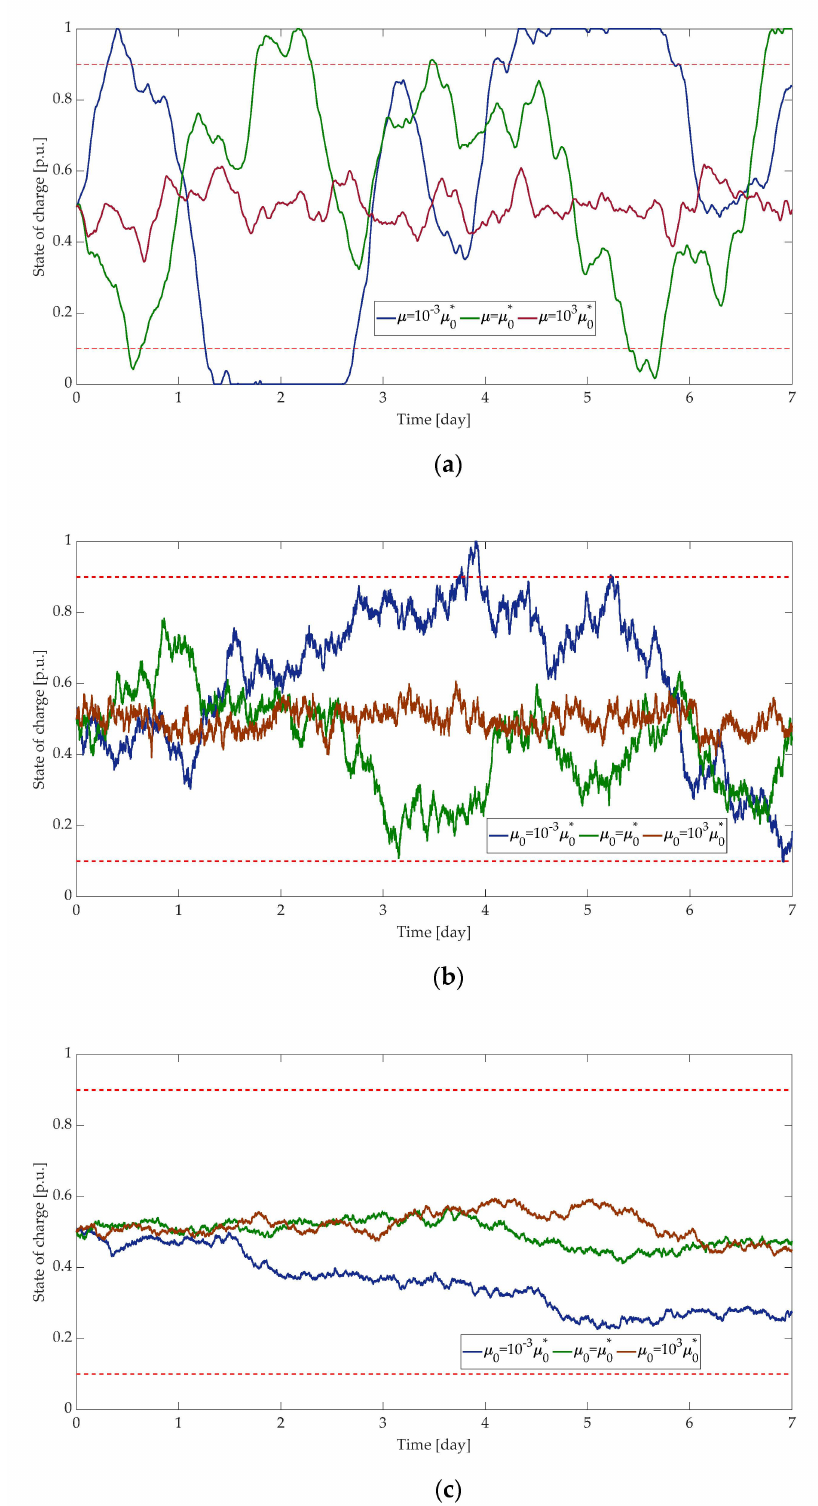
Figure 18. Examples of synthetic SoC profiles over a week in Case 1 ( a ), Case 2 ( b ), and Case 3 ( c